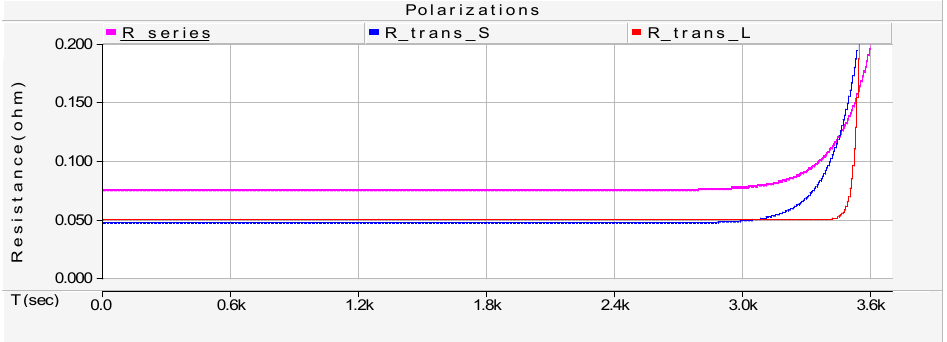
Figure 4. Change of battery polarizations with decrease in SOC along a time axis.